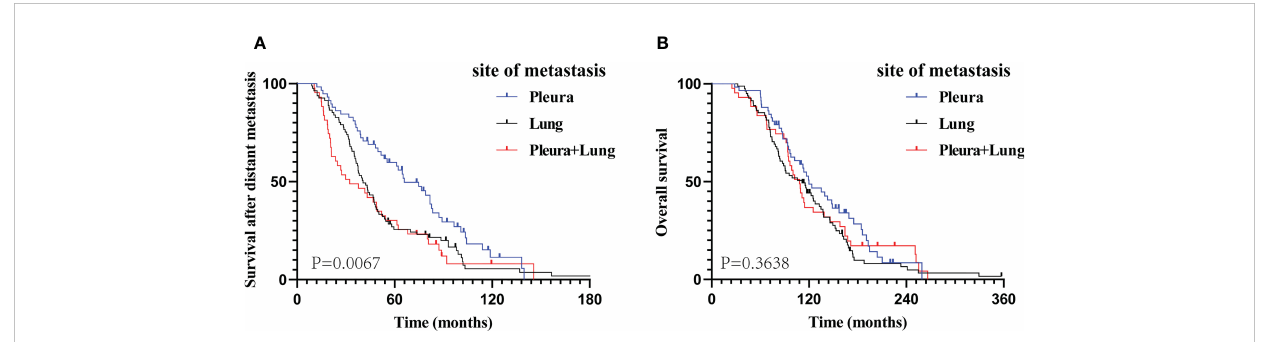
FIGURE 2 The Kaplan – Meier curve analysis of study cohorts. M-OS (A) and OS (B) curves according to different metastatic sites at the time of diagnosed of metastatic breast cancer. M-OS, survival after distant metastasis; OS, overall survival.